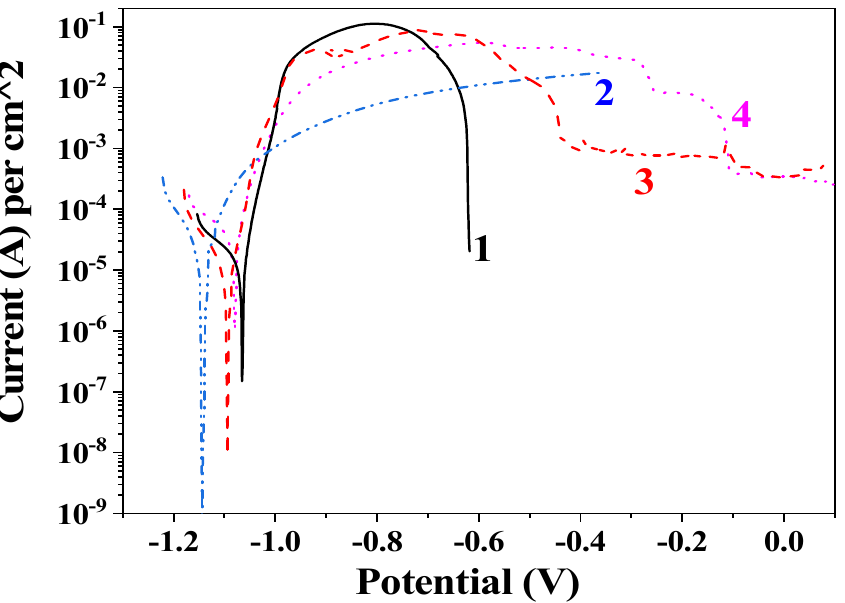
Figure 5. Potentiodynamic polarization curves of ordinary zinc coating in ( 1 ) NaCl and ( 2 ) ASW and hybrid zinc coating in ( 3 ) NaCl and ( 4 ) ASW. Table 1. Electrochemical parameters obtained from potentiodynamic polarization measurements.